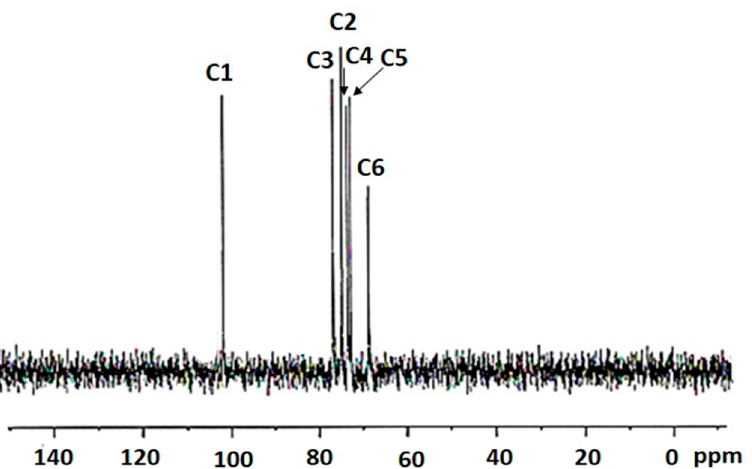
Figure 3. The 13 C NMR spectra showing intensity peaks of the extracted EPS from Apilactobacillus waqarii in D 2 O.